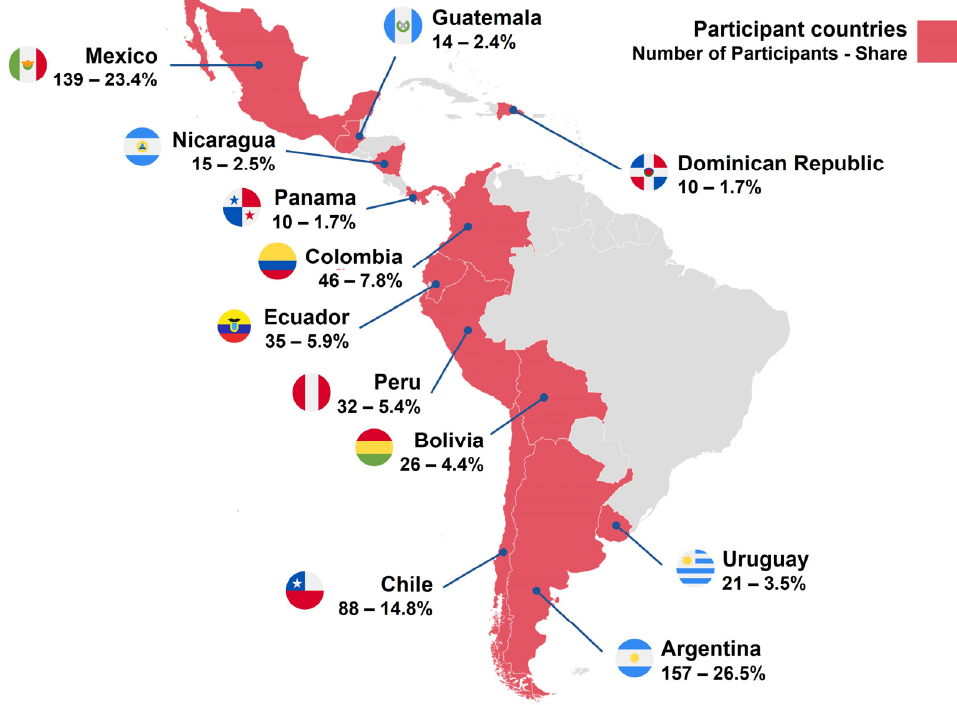
Figure 3. Participant